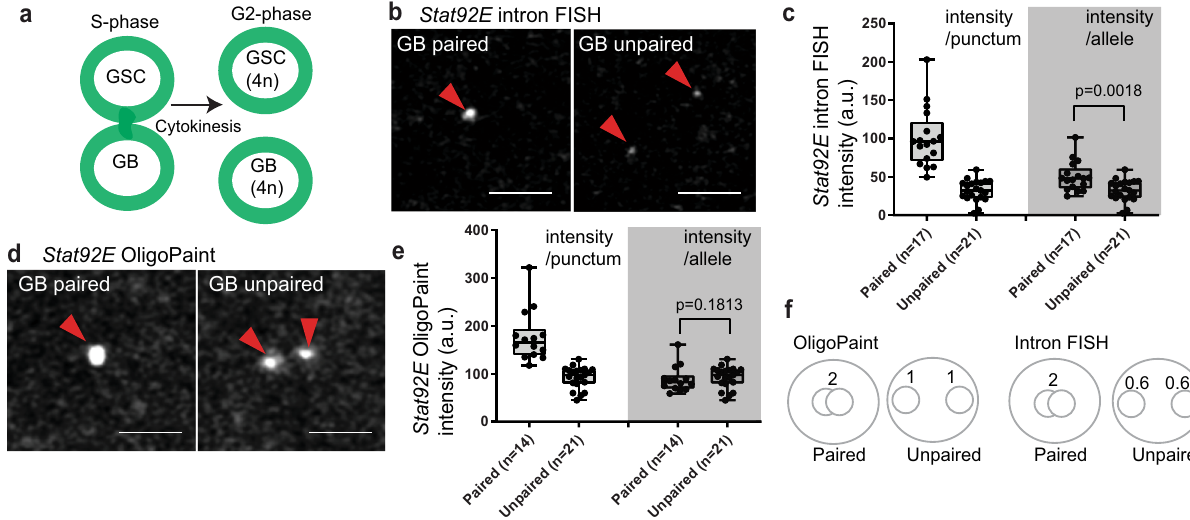
Fig. 5 Stat92E nascent transcript level differs in paired and unpaired conditions. a Schematic of cell cycle stages of a GSC and GB pair. b Representative images of Stat92E nascent transcripts in GBs. Left and right panel show paired or unpaired Stat92E homologous alleles, respectively. Red arrowheads indicate Stat92E nascent transcripts. c Quanti fi cation of nascent transcript intensity (measured as a ratio relative to nascent transcript intensity of CySC ’ s, see Method for details) in paired and unpaired conditions of GBs. Left two columns show intensity/punctum. Right two columns show intensity/allele. To plot intensity/allele, measured intensities of paired cases were divided by two. d Representative images of Stat92E DNA FISH in GBs. Left and right panel show paired or unpaired Stat92E homologous alleles, respectively. Red arrowheads indicate Stat92E locus visualized by DNA FISH. e Quanti fi cation of DNA FISH signal intensity in paired and unpaired conditions of GBs. Left two columns show intensity/punctum. Right two columns show intensity/allele. To plot intensity/allele, measured intensities of paired cases were divided by two. f A schematic of the intensity measurement results shown in ( c ) and ( e ). Box plots show 25 – 75% (box), median (band inside) and minimum to maximum (whiskers) with all data points. The p values were calculated by two-tailed Student ’ s t-tests. All scale bars represent 2 μ m. Number of scored cells, which are randomly chosen from at least 10 testes for each experiments, is shown for each data